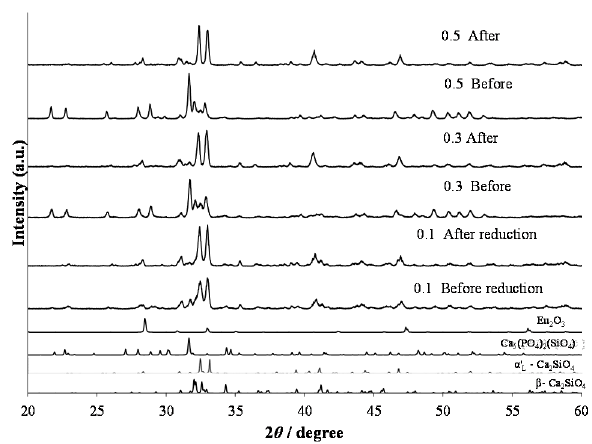
Figure 9. XRD patterns of (Ca 1.97– y Eu 2+ y □ 0.03 )(Si 0.94 P 0.06 )O 4 phosphors with ( y ) = 0.1, 0.3, and 0.5 annealed at 1473 K and consequently reduced under a 97% Ar–3% H 2 reductive atmosphere.